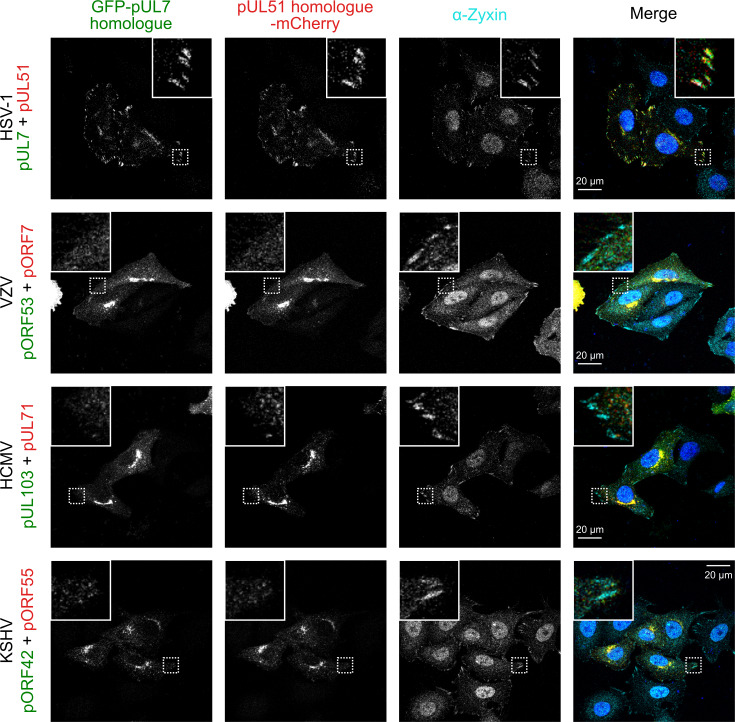
The pUL7:pUL51 complex from HSV-1 co-localizes with focal adhesion marker zyxin but homologues from other human herpesviruses do not.HeLa cells were co-transfected with GFP-pUL7 and pUL51-mCherry, or with similarly-tagged homologues from VZV, HCMV and KSHV. Cells were fixed 24 hr post-transfection and immunostained for the focal adhesion marker protein zyxin before imaging by confocal microscopy. Co-localization between the GFP, mCherry and far-red (zyxin) fluorescence was only observed for cells transfected with HSV-1 pUL7-GFP and pUL51-mCherry. Images are representative of experiments performed in three cell lines (TERT-immortalized human foreskin fibroblasts, U2-OS osteosarcoma cells and HeLa cells) by two independent scientists.